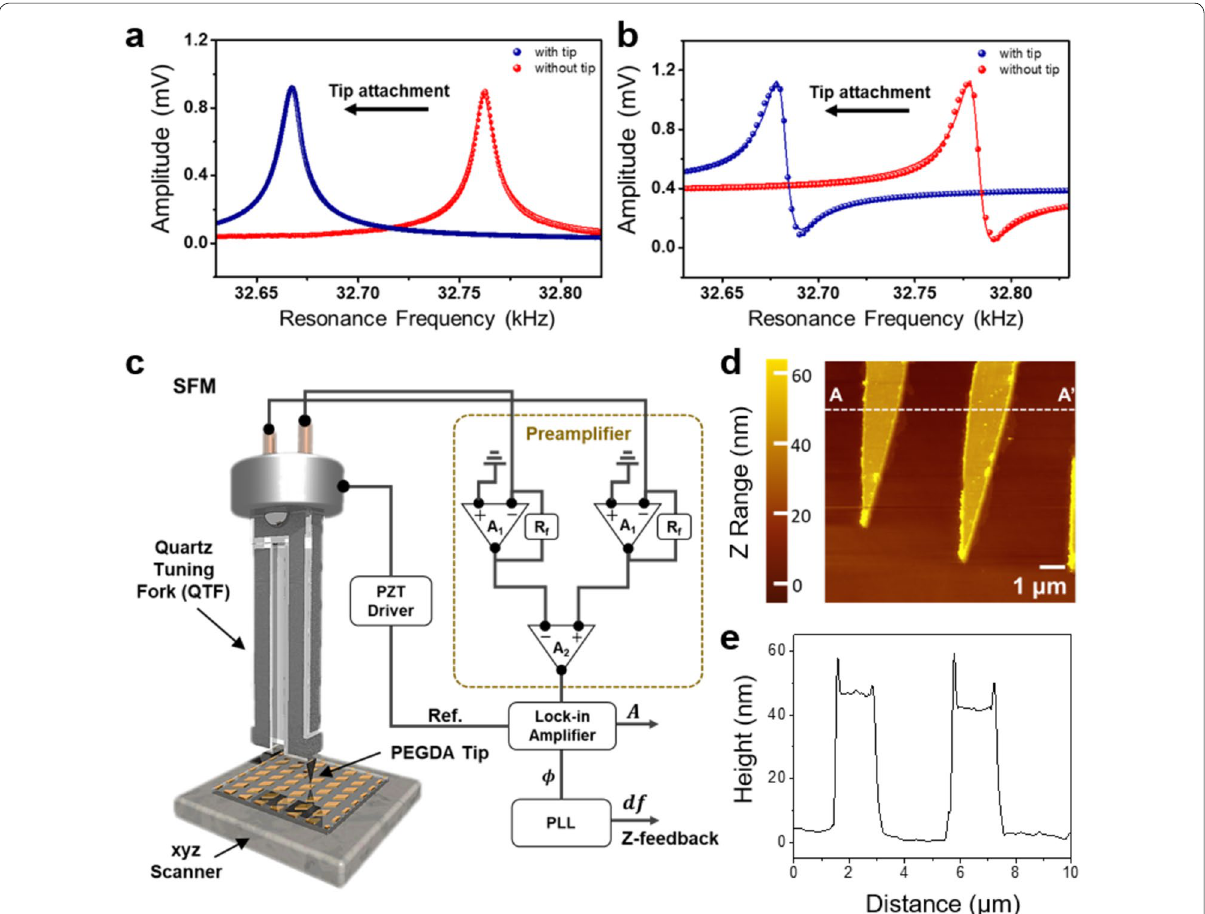
Fig. 3 Shear force microscopy (SFM) with the PEGDA tip attached quartz tuning fork. Amplitude spectra of QTFs before and after the PEGDA tip attachment by a optical and b electrical readouts. c Schematic and circuit diagram for SFM. d Dynamic mode topography and e a linescan of a calibration sample along the dashed line A–A